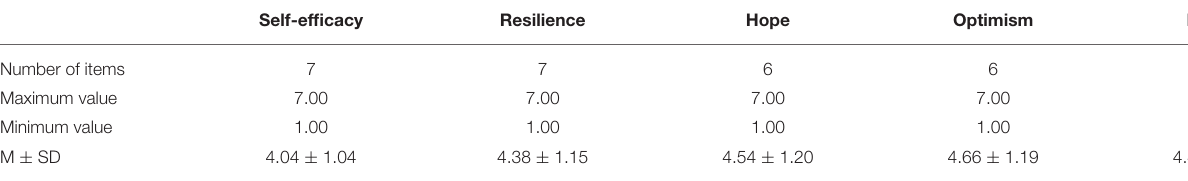
TABLE 6 | Descriptive results of USWL’ PsyCap at pretest (M ± SD).